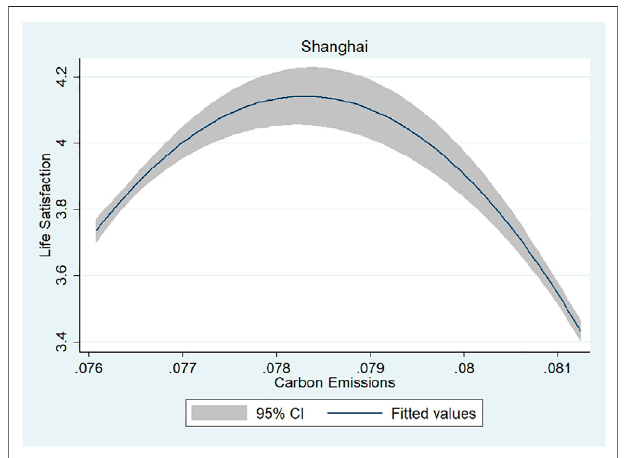
FIGURE 3 | The relationship between carbon emissions and life satisfaction in Shanghai. Note: Quadratic fi t is shown with 95% con fi dence intervals. All data are averaged over the 2010 – 2018 period.